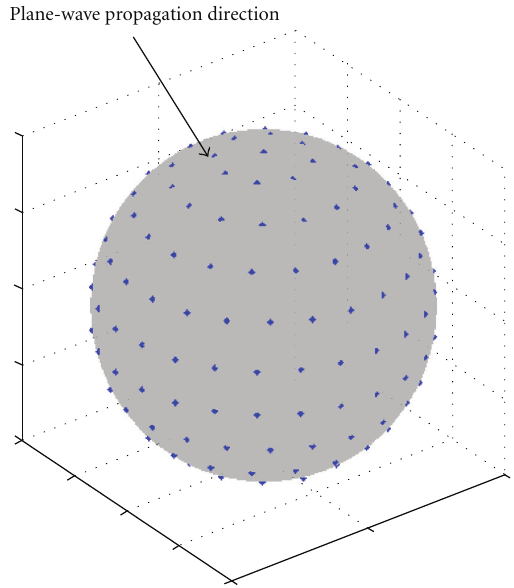
Figure 3: A selection of points ( θ s , φ s ), s = 1,2, ... , S , evenly distributed on the unit sphere. Each point defines a direction of propagation for two plane waves. One plane wave is θ -polarized, the other is φ -polarized.